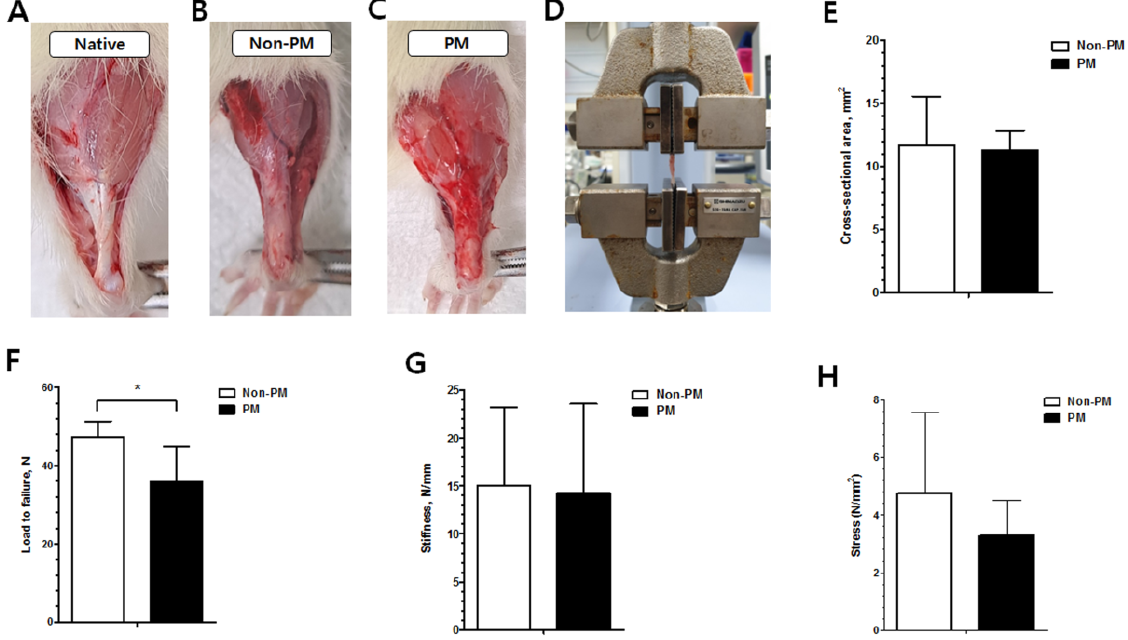
Figure 4. ( A – C ) Gross images of the tendons in native, control (non-PM), and PM-exposed rats 6 weeks post-operation. ( D ) Biomechanical testing machine. ( E ) Cross-sectional area, ( F ) load to failure, ( G ) stiffness, and ( H ) stress outcomes. * p <